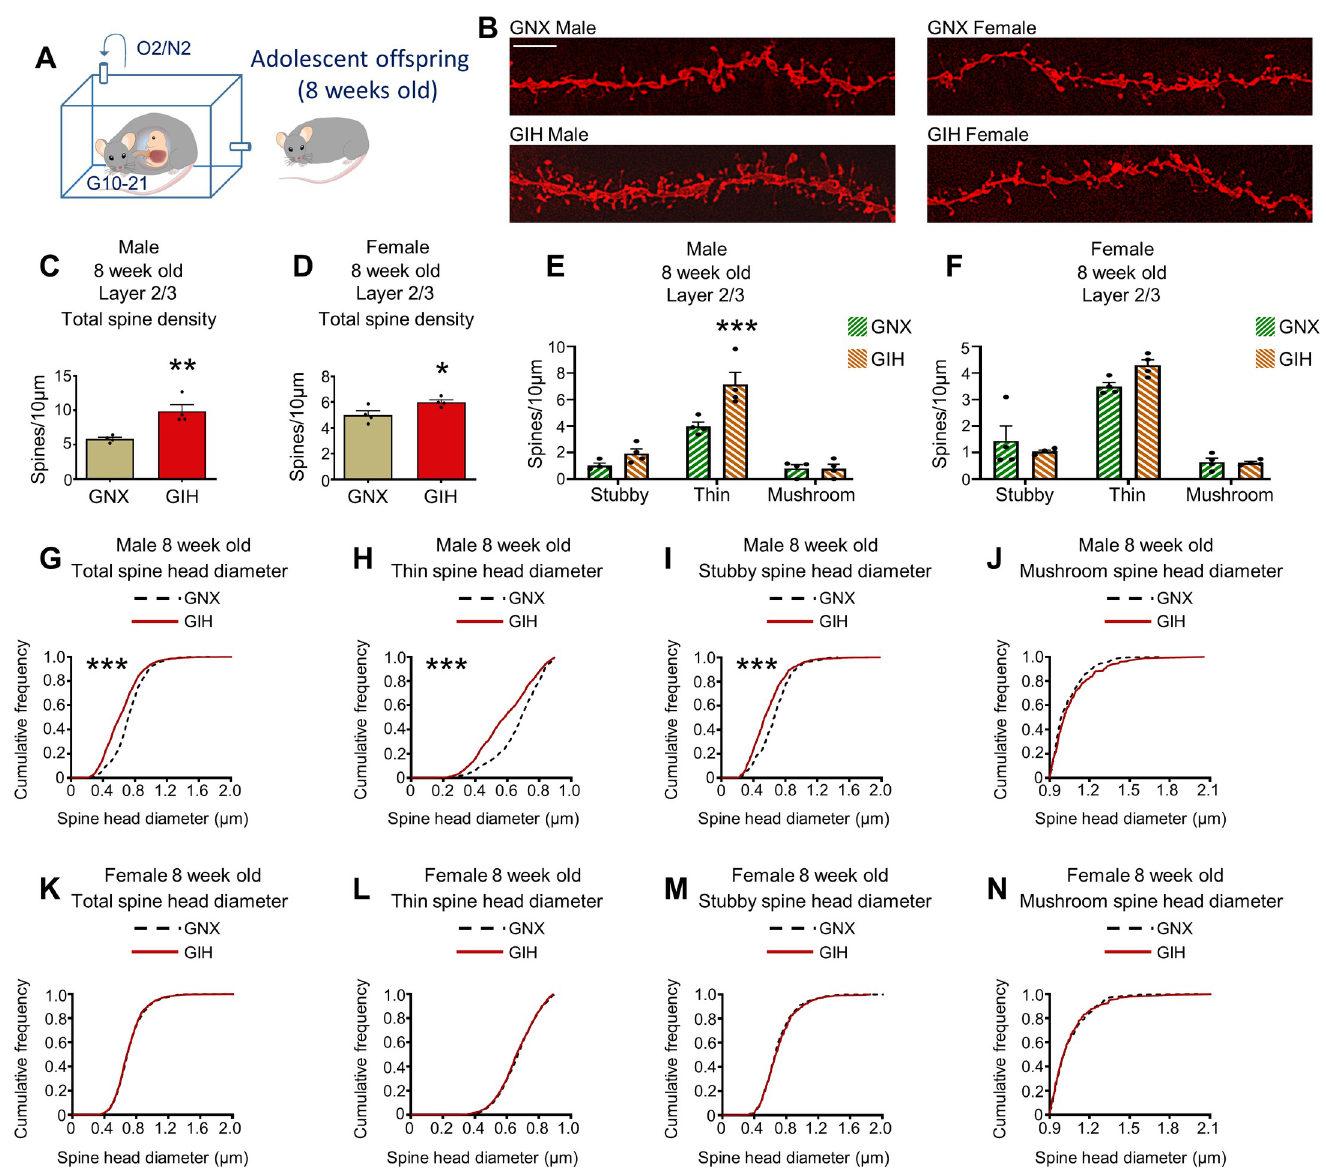
Fig 4. mPFC pyramidal neuronal dendritic spine density and morphology is altered in layer 2/3 in 8-week-old GIH offspring. (A) Schematic depicting GNX and GIH offspring age pertaining to all data in Fig 4 . (B) Representative layer 2/3 pyramidal neuron dendrite segments from 8-week-old male and female GNX and GIH offspring. Scale bar = 10 μ m. (C) Assessment of layer 2/3 total dendritic spine density revealed a significant increase in male GIH offspring relative to male GNX offspring [t (df,6) = 4.065, p = 0.0066]. n = 4 GNX and 4 GIH rats. (D) Assessment of layer 2/3 total dendritic spine density revealed a significant increase in female GIH offspring relative to male GNX offspring [t (df,6) = 2.651. p = 0.0380]. n = 4 GNX and 4 GIH rats. (E) Spine subtype density analysis revealed a significant increase in thin spine density in male GIH offspring [Bonferroni post hoc (df,18) p = 0.0004] and no alteration in the density of stubby [Bonferroni post hoc (df,18) p = 0.5560] or mushroom spines [Bonferroni post hoc (df,18) p = 1.0]. n = 4 GNX and 4 GIH rats. (F) No differences in the density of any spine subtypes were identified between female GIH and GNX offspring [Bonferroni post hoc stubby (df,18) p = 0.8745, thin p = 0.1296, mushroom p = 1.0]. n = 4 GNX and 4 GIH rats. (G) Analysis of cumulative total spine head diameter curves revealed a significant leftward shift in the curve for male GIH offspring (median survival differential 15.58%; χ 2 = 229.0, p < 0.0001). n = 1,750 GNX and 2,869 GIH spines. (H) Analysis of cumulative thin spine head diameter curves revealed a significant leftward shift in the curve for male GIH offspring (median survival differential 15.24%; χ 2 = 168.3, p < 0.0001). n = 1,169 GNX and 1,974 GIH spines. (I) Analysis of cumulative stubby spine head diameter curves revealed a significant leftward shift in the curve for male GIH offspring (median survival differential 18.41%; χ 2 = 34.67, p < 0.0001). n = 302 GNX and 618 GIH spines. (J) No significant differences in the cumulative mushroom spine head diameter curve were identified between male GIH and GNX offspring (median survival differential 2.3%). n = 279 GNX and 277 GIH spines. (K–N) No significant differences in total or spine subtype cumulative head diameter curves were identified between female GIH and GNX offspring (total spine median survival differential 0.63%, thin differential 1.14%, stubby differential 1.12%, and mushroom differential 0.15%). n = 2,682 GNX and 2,245 GIH total spines; 1,866 GNX and 1,635 GIH thin spines; 507 GNX and 374 GIH stubby spines; 309 GNX and 236 GIH mushroom spines. All bar graphs are the mean + SEM. The data underlying this figure can be found in S1 Raw Data. GIH, gestational intermittent hypoxia; GNX, gestational normoxia; mPFC, medial prefrontal cortex.